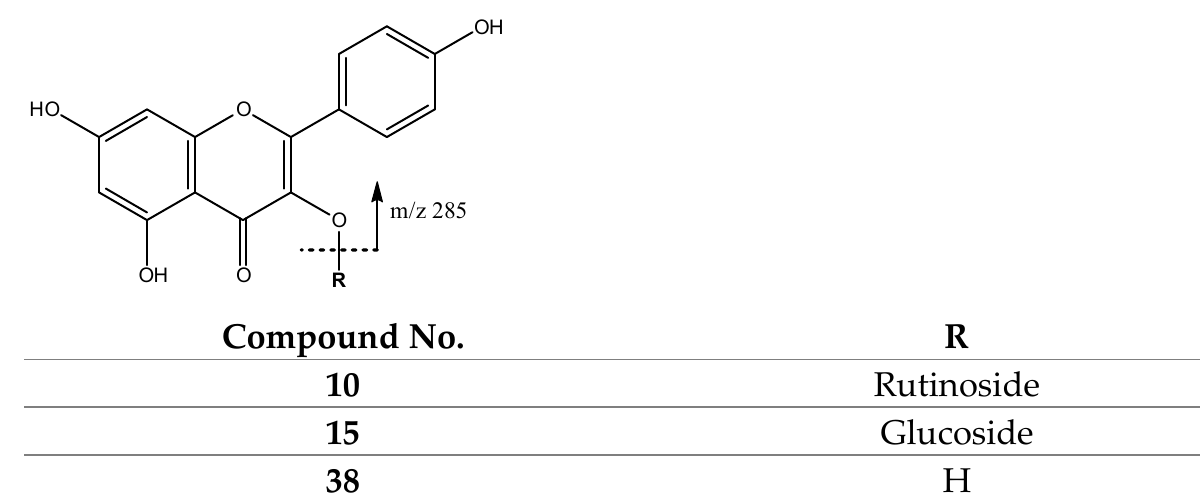
Figure 20. Kaempferol and derivatives’ structure and fragmentation.